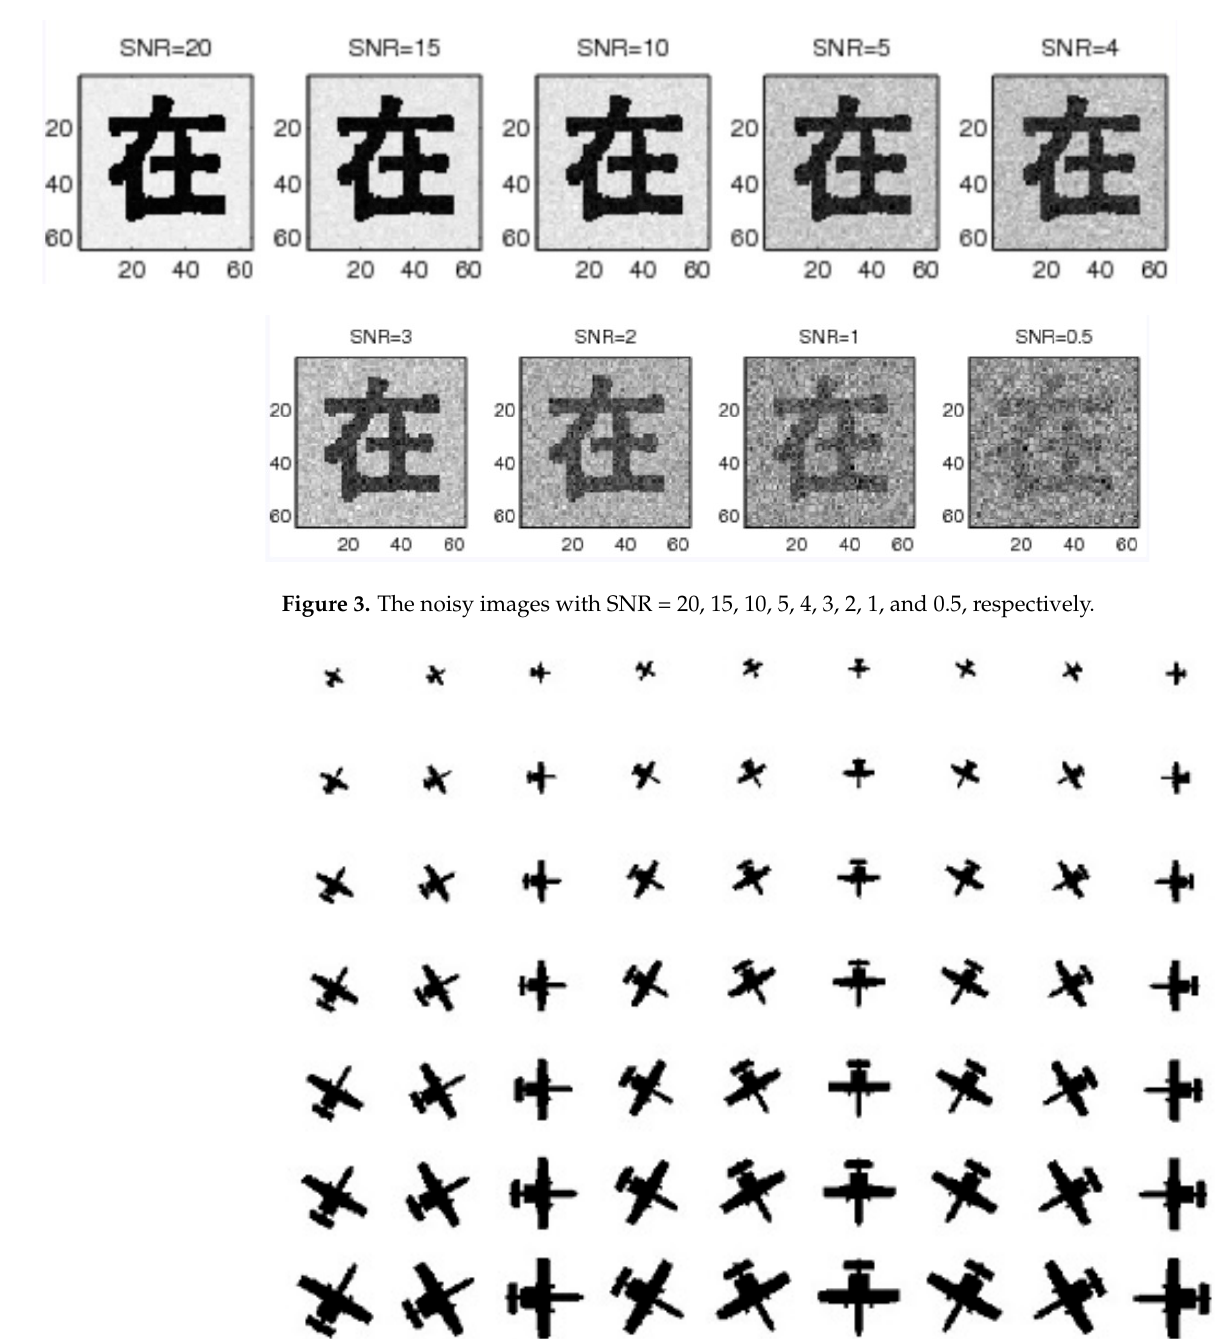
Figure 4. A combination of scaling factors (0.2, 0.3, 0.4, 0.5, 0.6, 0.7, 0.8, 0.9, and 1.0) and rotation